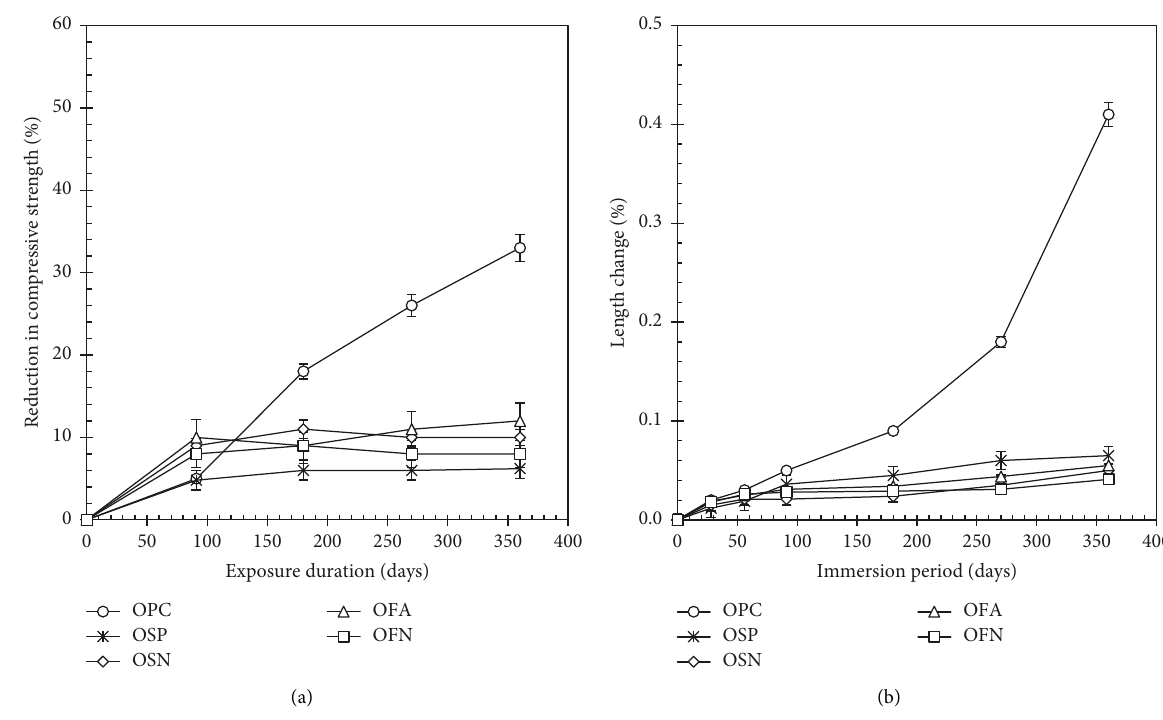
Figure 7: Resistance to sulfate attack of